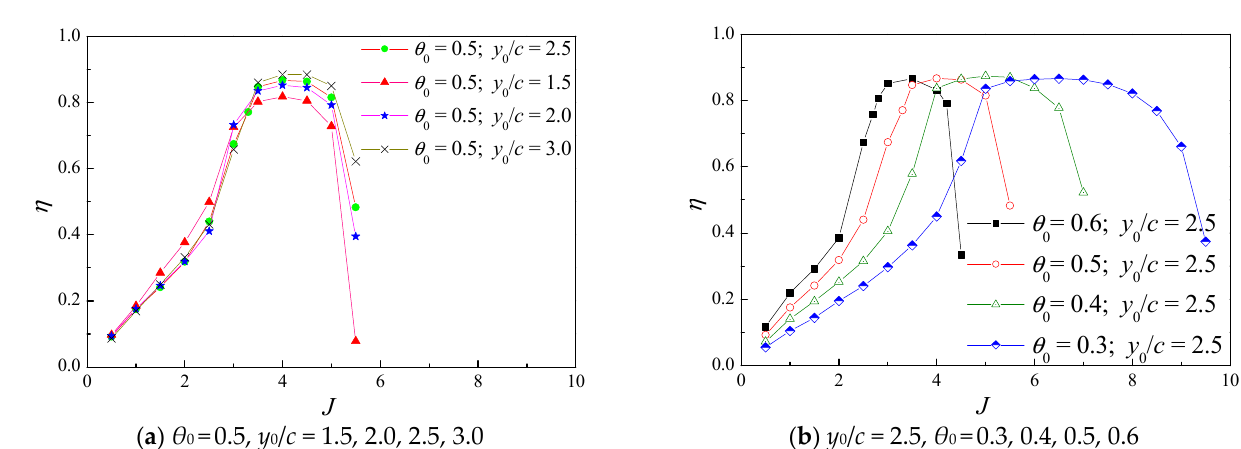
Figure 13. Propulsive efficiency η as function of advance coefficient J , for different heaving amplitude and pitching am- plitude.